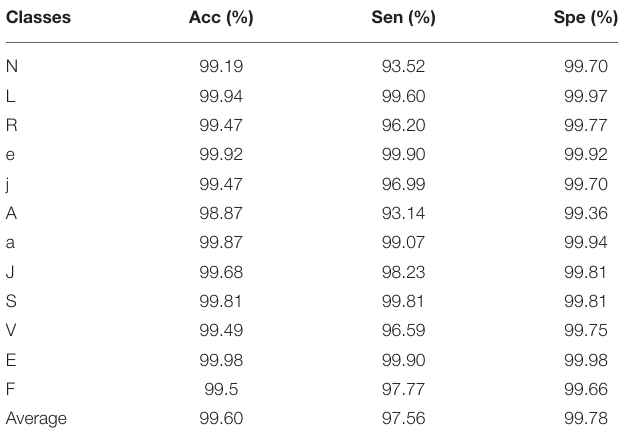
TABLE 3 | The results of each category on testing